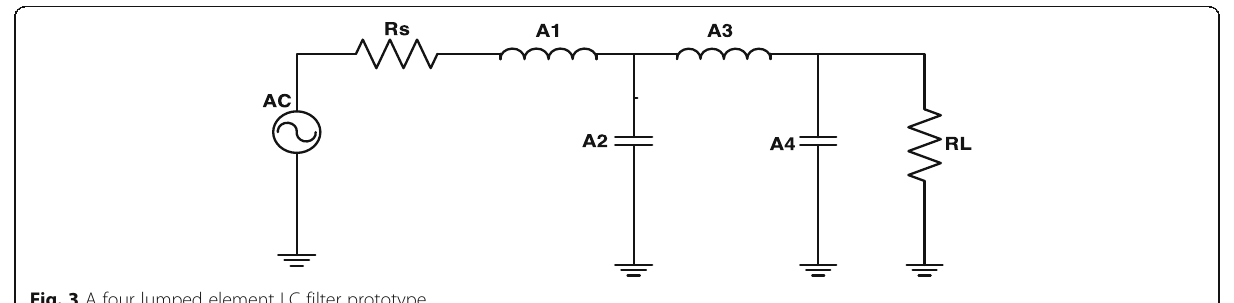
Fig. 3 A four lumped element LC filter